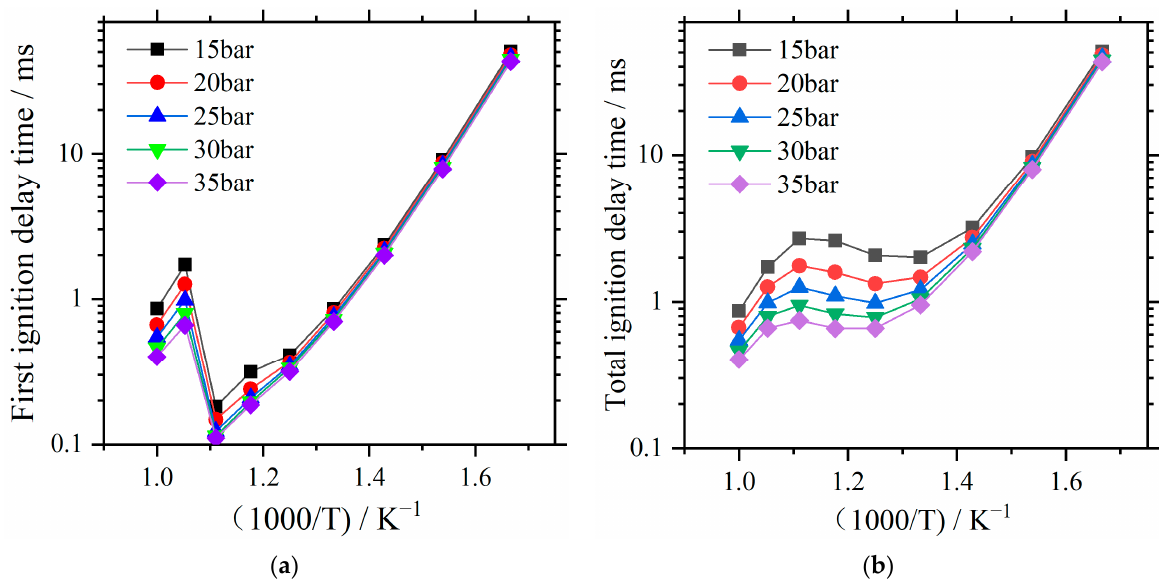
Figure 2. Results of the ignition delay time of kerosene under different pressures: ( a ) first ignition delay time; ( b ) overall ignition delay time .